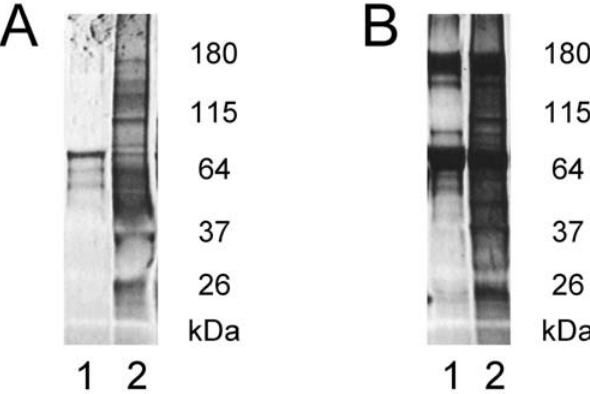
Figure 2. ESMVs contain protein. Insoluble and soluble protein fractions were isolated from ESMVs and separated on a Tris-glycine buffered 4–20% SDS-polyacrylamide gel, stained with SYPRO Ruby Red. (A) The insoluble protein fraction. Lanes: (1) control medium, (2) ESMVs. (B) The soluble protein fraction after precipitation with TCA. Lanes: (1) control medium, (2) ESMVs. Equivalent amounts of sample and control medium were processed.